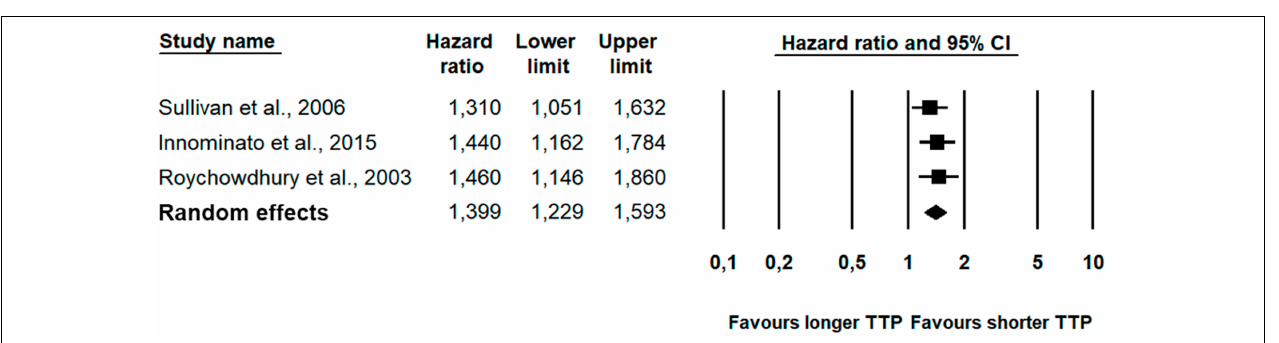
FIGURE 4 | Forest plot of poorer self-reported sleep and time to progression